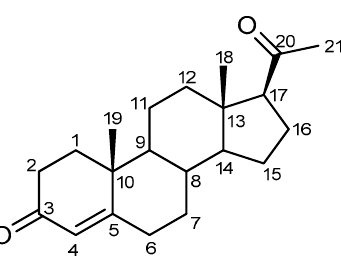
Figure 1. Chemical structure of progesterone.